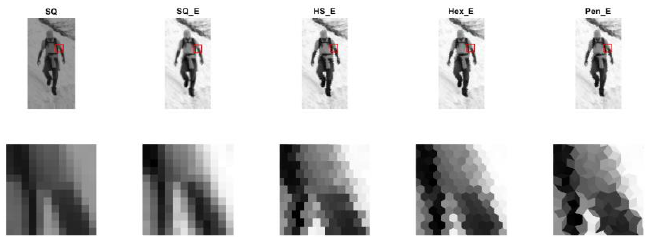
Figure 8. One of original images and its set of generated images.